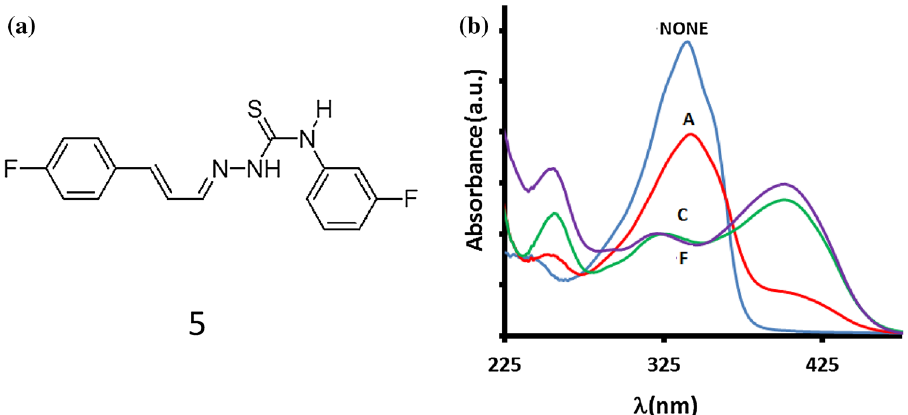
Figure 5. ( a ) Structure of probe 5 . ( b ) Change in spectrum of probe 5 (30 μM) upon the addition of 10 mM acetate (A), cyanide (C), or fluoride